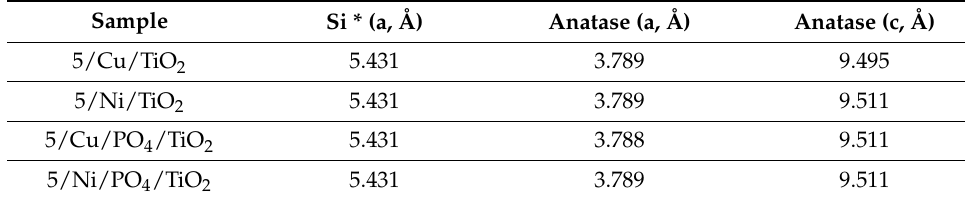
Table 2. Lattice parameters of the TiO 2 anatase phase in different samples.